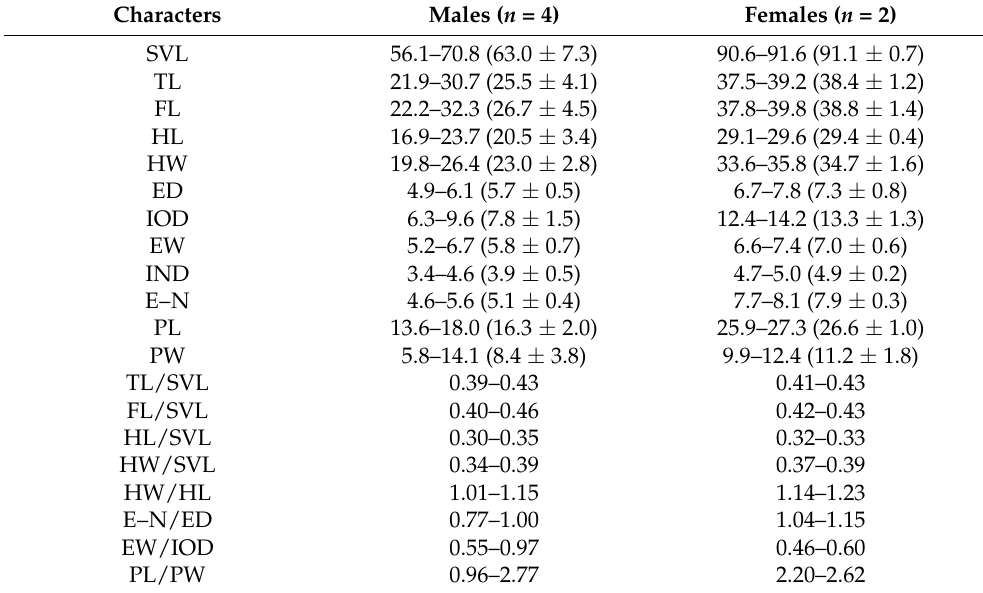
Table A2. Ranges (in mm) and proportions of adult male and female types of Rhinella moralesi sp. nov.; ranges followed by means and one standard deviation in